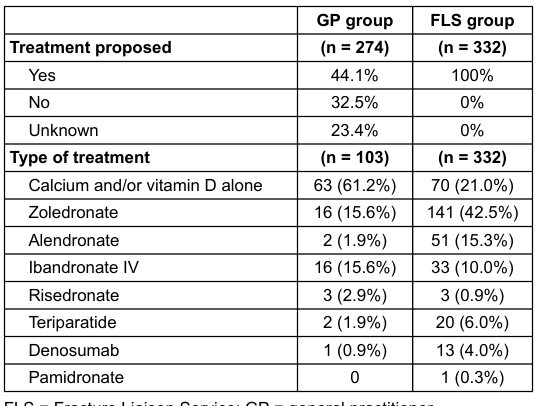
Table 5: Mortality after 1 year and after a mean follow-up of 5.62